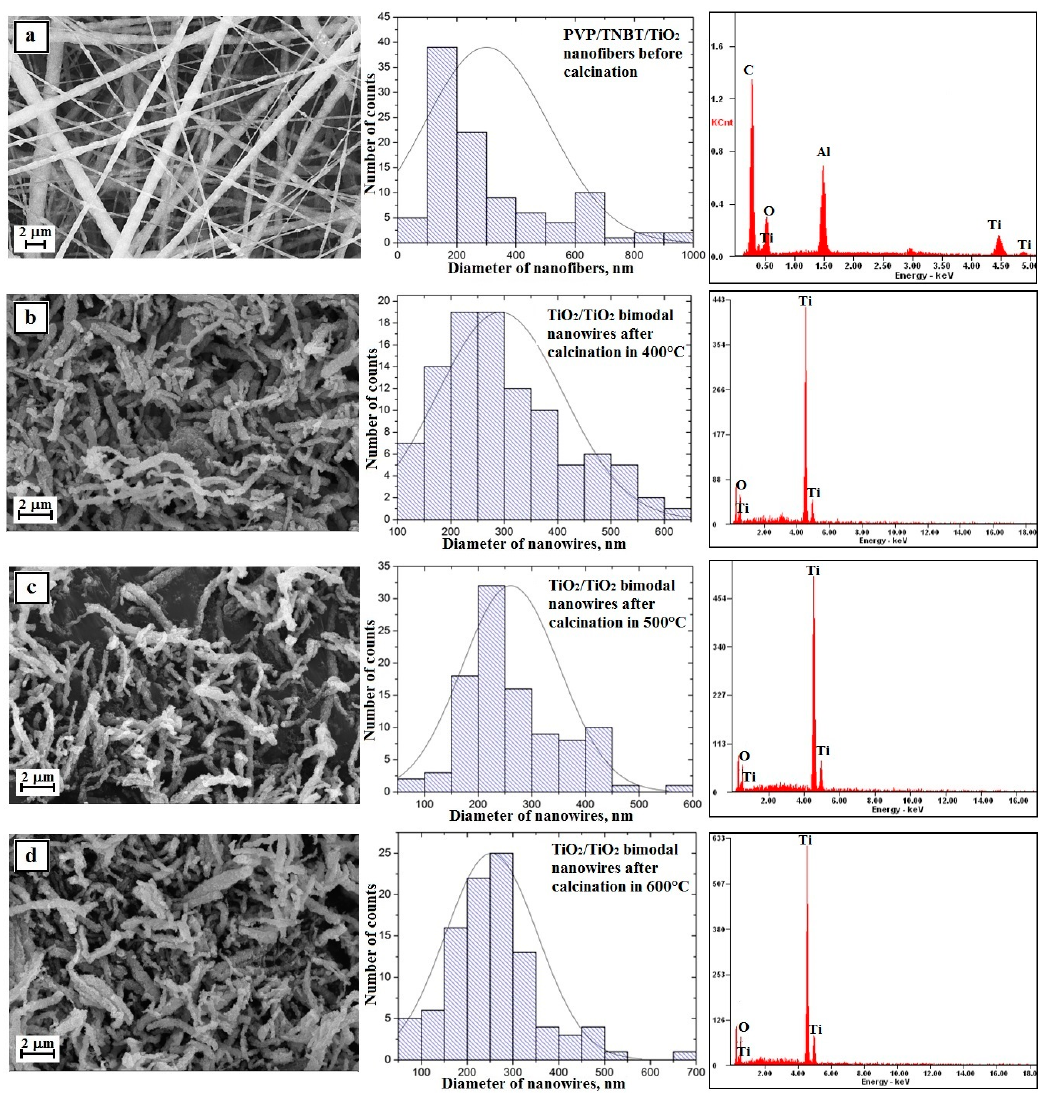
Figure 9. Left: SEM image of the topography on the surface of the formed fibrous composite mats and obtained nanowires; Middle: histograms presenting the distribution of hundredfold measurement of the diameter of randomly selected: ( a ) nanofibers obtained from PVP/TNBT/TiO 2 /AcOH/EtOH solution, ( b – d ) bimodal TiO 2 /TiO 2 nanowires after calcination in 400 ◦ C, 500 ◦ C, and 600 ◦ C; Right: obtained EDS spectra (peaks of Al derive from the substrate on which nanofibres were deposited, while Au and Pd derive from the conductive layer sputtered onto the produce nanostructures) from the entire area shown in the SEM images and TEM images for TiO 2 nanowires obtained in 600 ◦ C an image in a light and dark area with diffraction image from single nanowires.